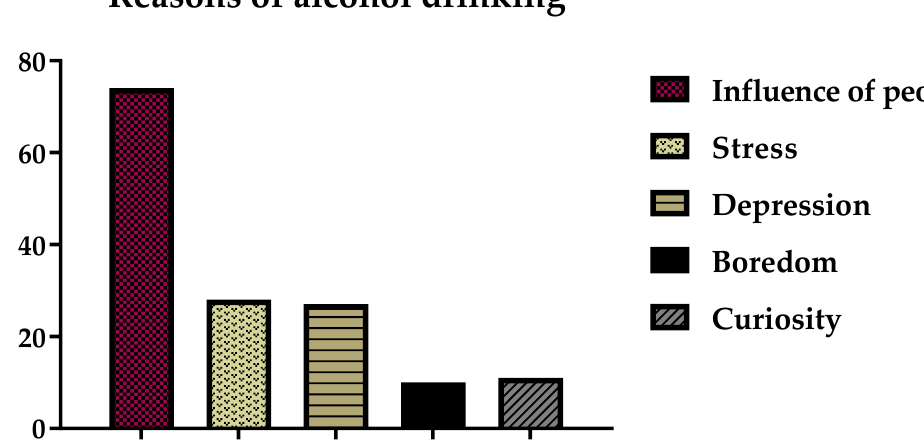
Figure 5. Reasons for alcohol drinking.